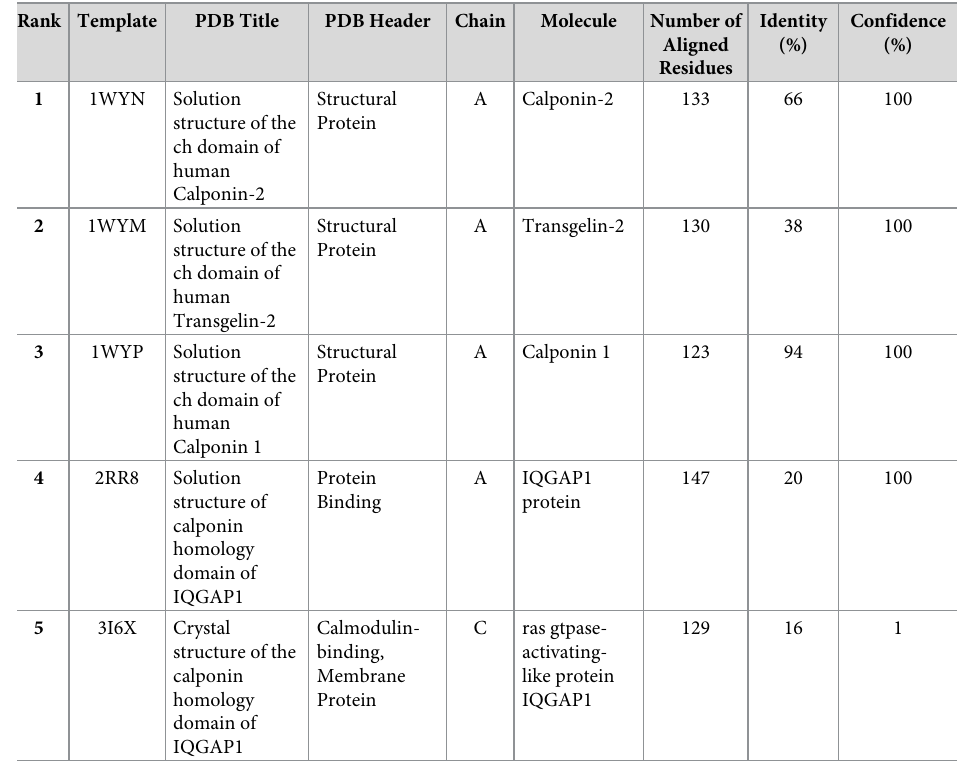
Table 8. Top 5 templates of CNN1 isoform 2 by PHYRE2